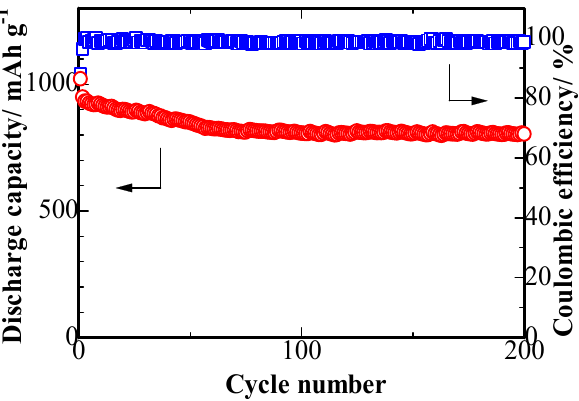
Figure 8. The cyclic performance of S/PPy/PG composite electrode at 0.1 C.